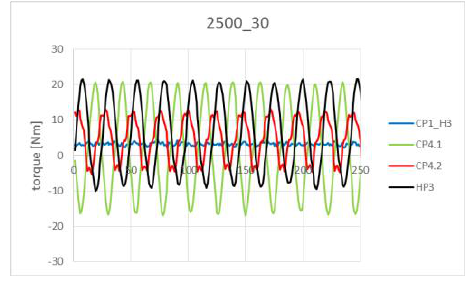
Fig. 8. Torque on the pump shaft at a pumping pressure of 30 MPa and a pump shaft speed of 2500 rpm The lowest torque amplitude value was registered for the CP1_H3 pump. The torque amplitude analysis ( Fig.